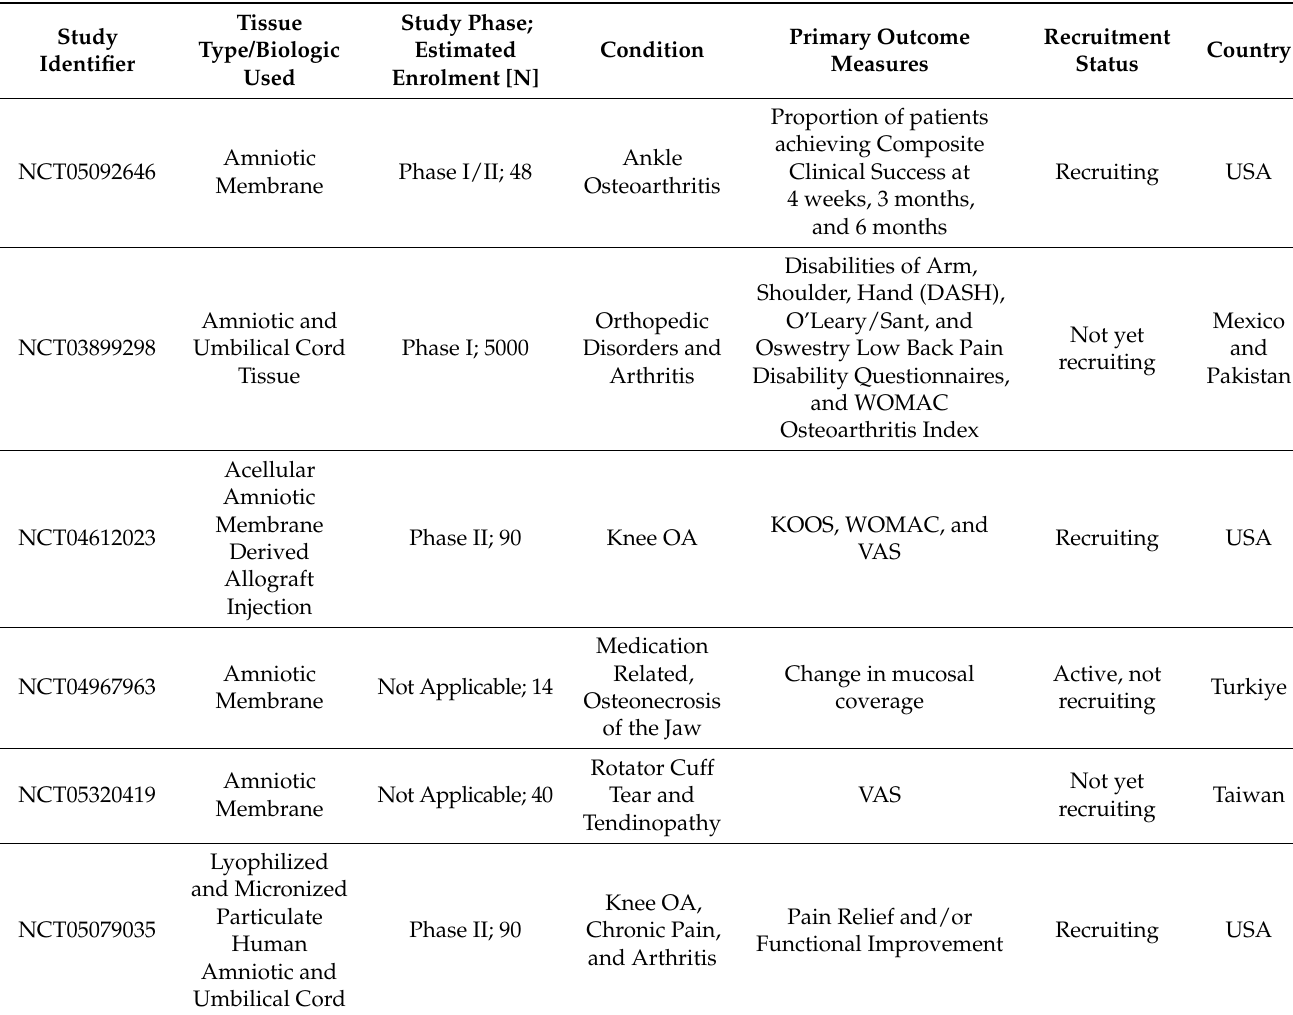
Table 3. Clinical trials registered on ClinicalTrials.gov till 10 October 2022 utilizing amniotic mem- brane tissue/cells, and its derivatives, for the treatment of orthopedic